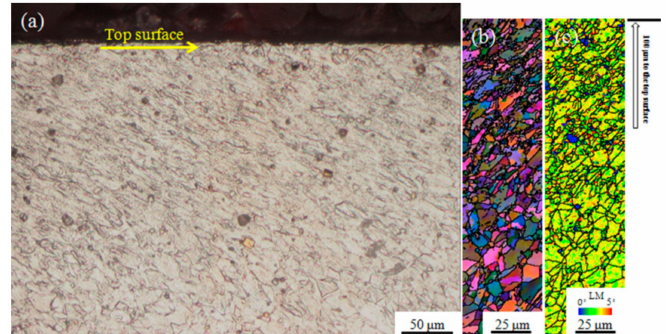
Figure 4. Optical and scanning electron microscope (SEM) morphologies of the as-received Inconel 718 superalloy: ( a ) Optical map, ( b ) SEM map.